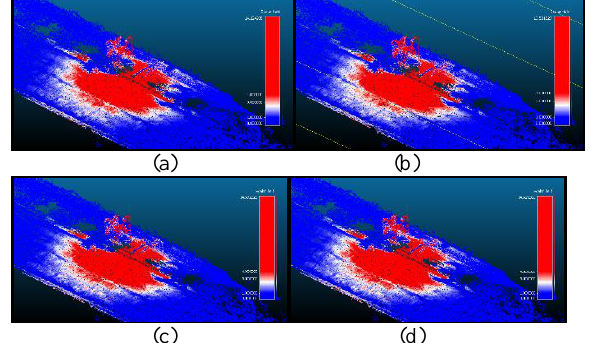
Figure 17. Illuminance data integrated 3D point cloud (a) red, (b) green, (c) blue, (d) function ND.